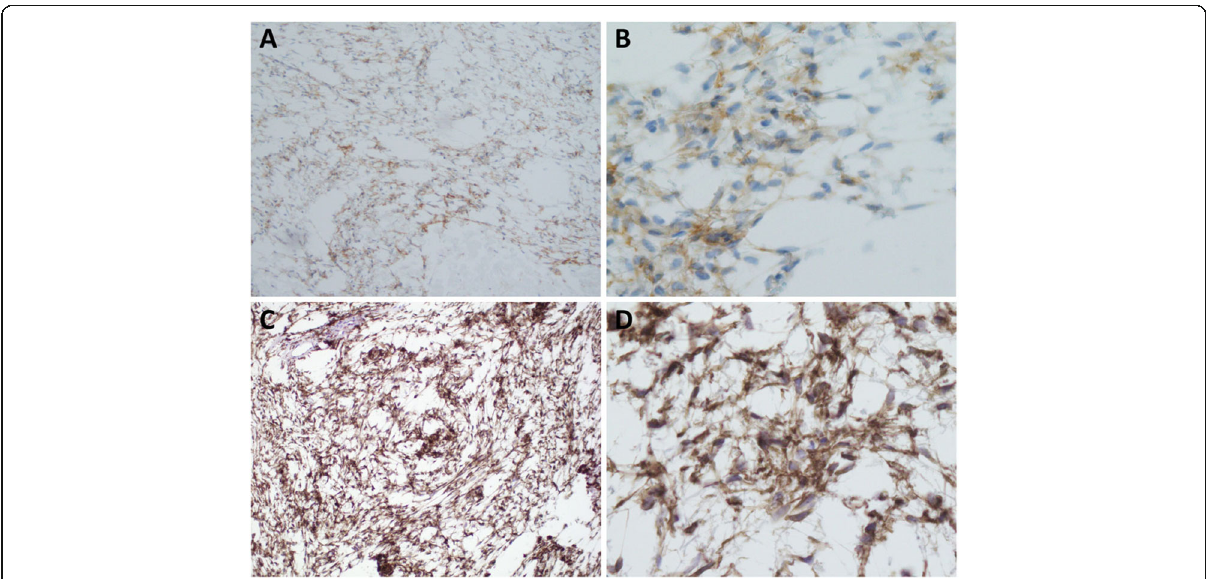
Fig. 4 The neoplastic cells were diffusely positive for DOG1 ( a , 10x; b , 40x) with moderate dense immunoreactivity, and diffusely and strongly for MUC4 ( c , 10x; d ,